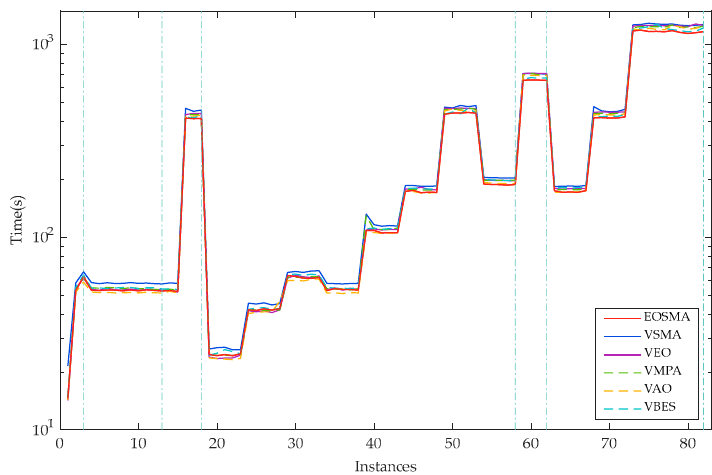
Figure 6. Average execution time of six algorithms on all instances.